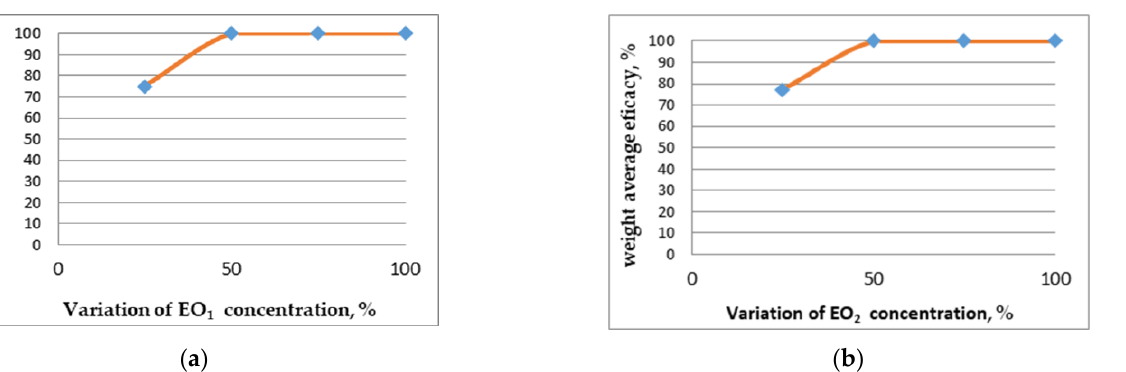
Figure 13. The dependence of the average temporal efficacy on the concentration, for EO 1 ( a ) and EO 2 ( b ) against B. cinerea.